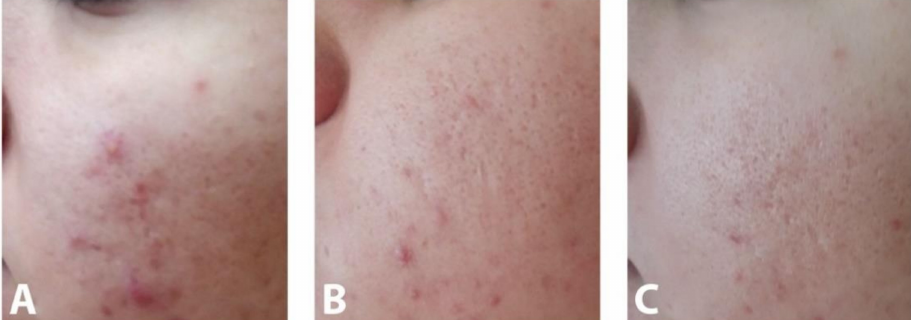
Figure 3. Patient with mild to moderate acne vulgaris at baseline ( A ), after four weeks ( B ) and after eight weeks ( C ) of treatment with AZA-NC